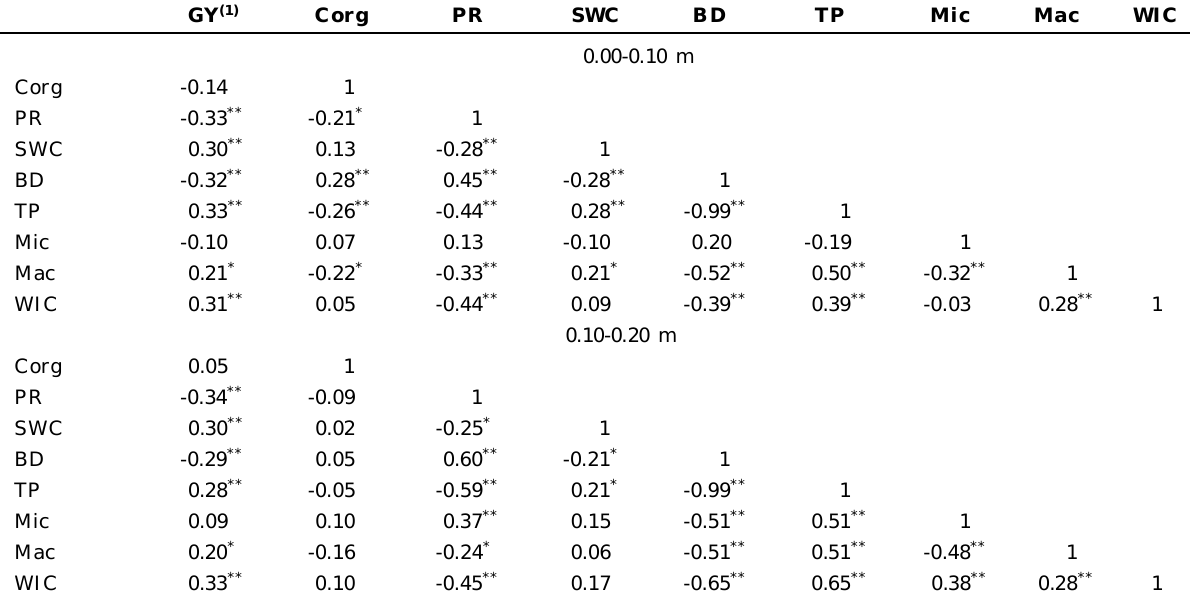
Table 6. Simple linear correlation matrix between variables studied in the plot, considering the evaluated soil